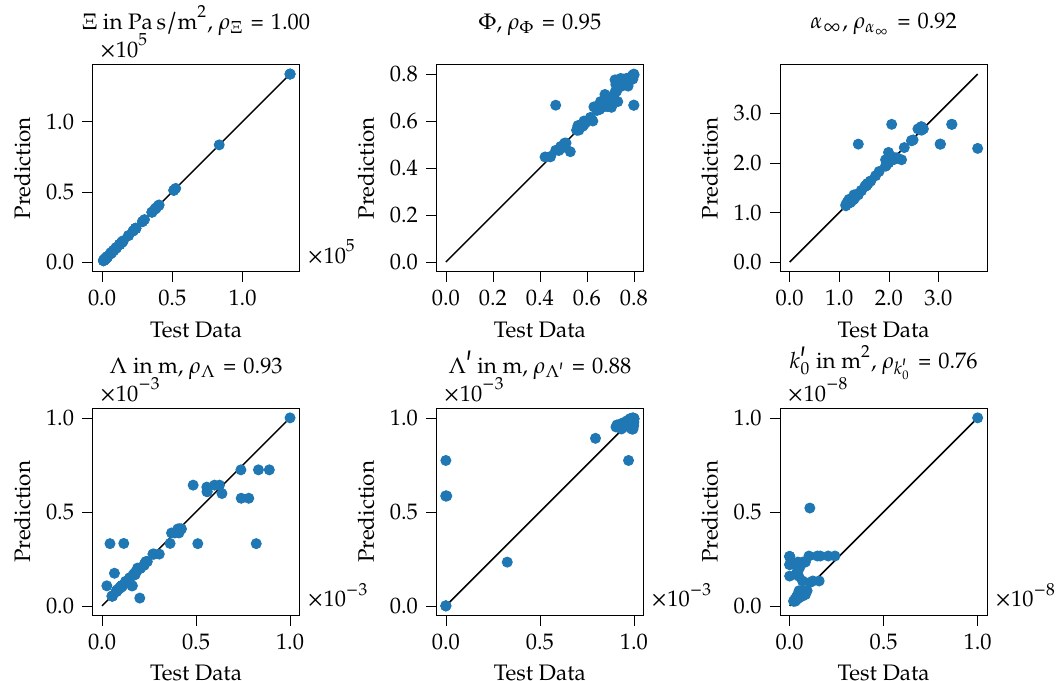
( a ) Comparison for specimen 39 with lowest mean absorption ( b ) Comparison for specimen 2 with highest mean absorption coefficient. It can be seen that the ML model resembles the coefficient. It can be seen that the ML model resembles the inversely identified parameters nearly perfectly, and both fit the inversely identified parameters nearly perfectly, and both fit the measurement to a high extend. measurement to a high extend. Figure 10. Comparison of the measured absorption coefficient, the absorption coefficient computed from the inversely iden- tified Biot parameters (’Fit’) and absorption coefficient computed using the Biot parameters outputted by the KNN model.